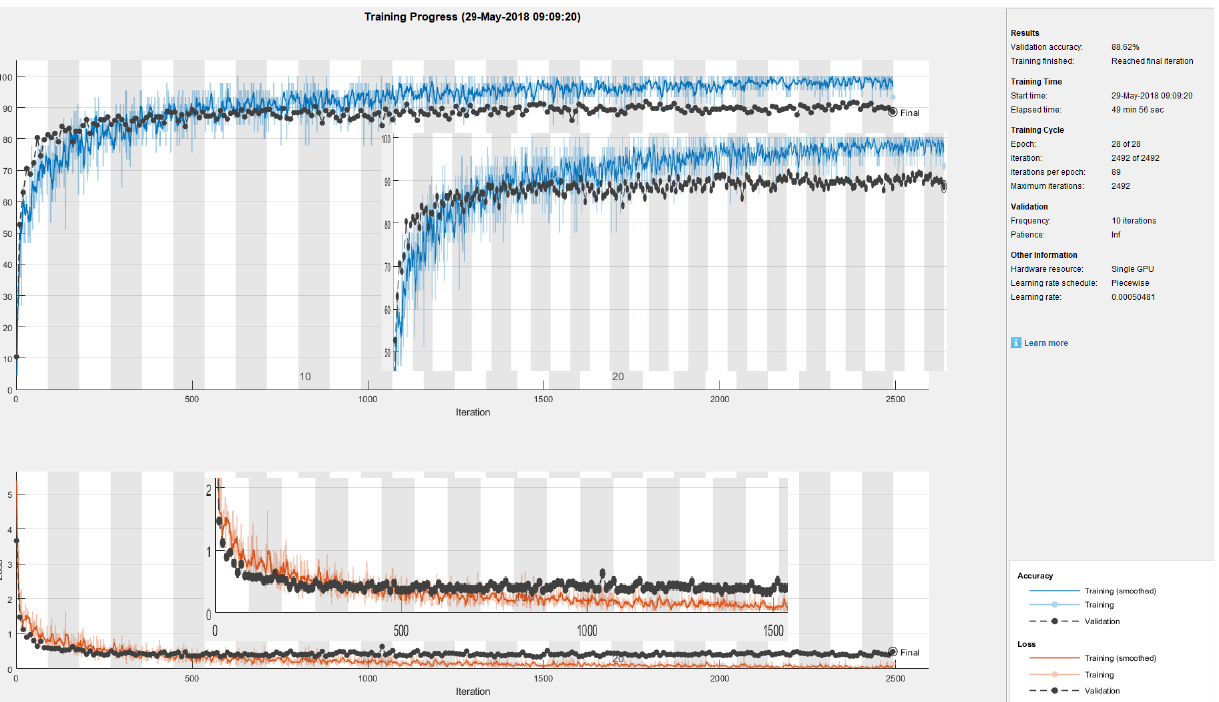
Fig. 8. The truncated TLCNN with 22 layers is trained less efficiently than a regular TLCNN with 25 layers (compare it to Fig. 6), although the odds are small.